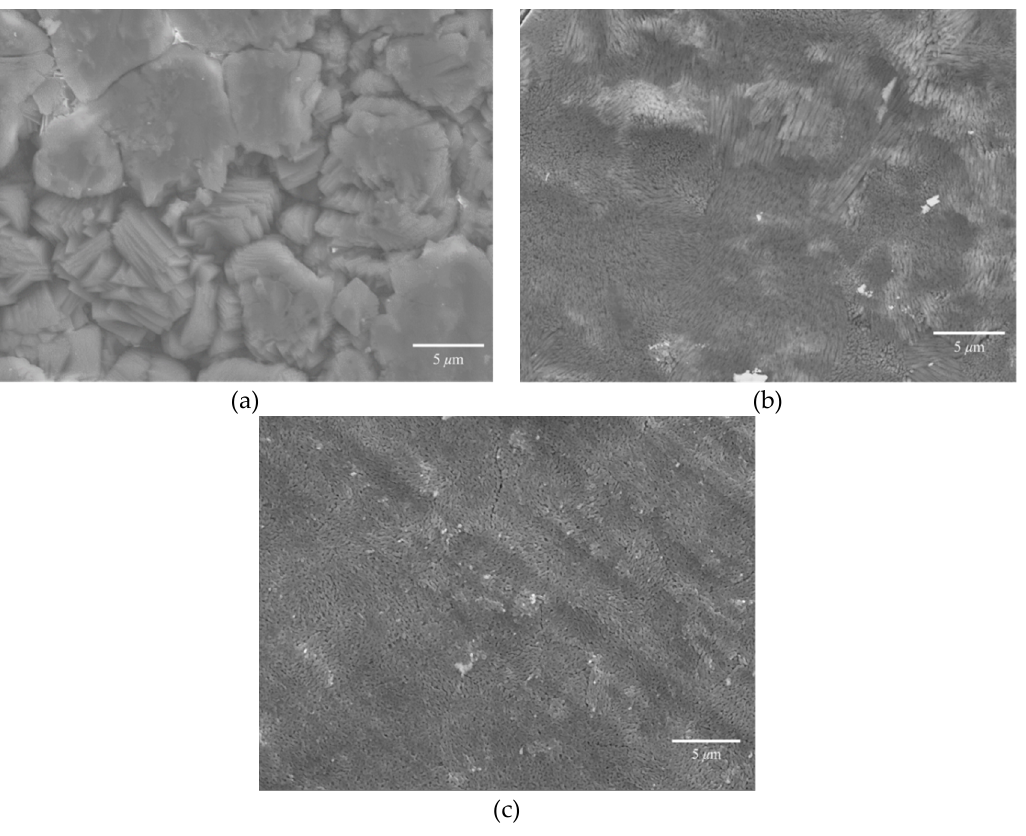
Figure 5. ( a ) SEM image of pressurized Sr-doped ACC sample (Sr/(Sr + Ca) = 0.05). ( b ) SEM image of heated Sr-doped ACC sample (Sr/(Sr + Ca) = 0.2). ( c ) SEM image of heated Ba-doped ACC sample (Ba/(Ba + Ca) = 0.45).